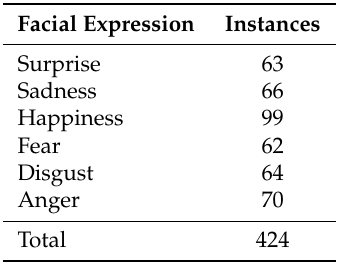
Table 2. Number of instances per facial expression.